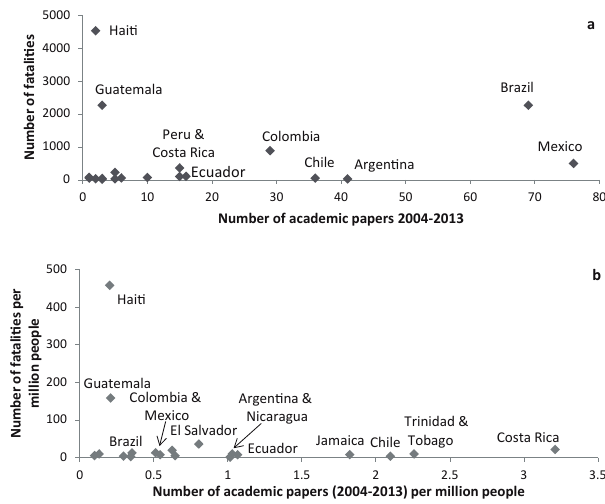
Figure 12. (a) Comparison of fatalities caused by landslides and FIGURE 12 scientific research illustrated by total number of papers (Web of Science databases) for the 2004–2013 period per country; (b) same indicators normalized by 2010 country